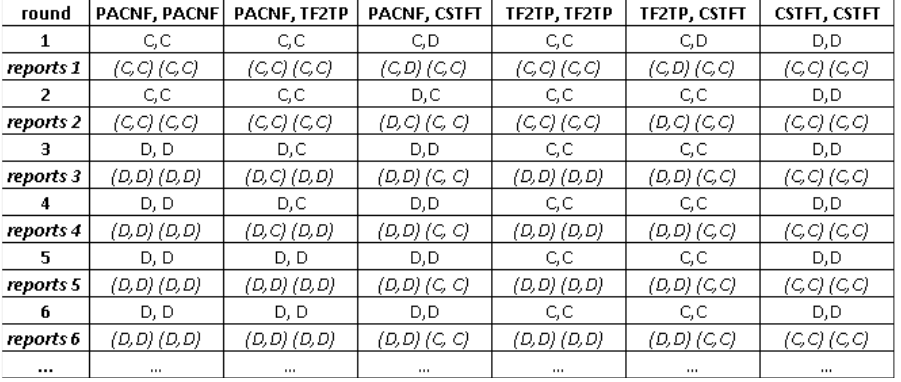
Patterns of interactions and reports for every possible pair of strategies in an exemplary population consisting of PACNF, TF2TP and